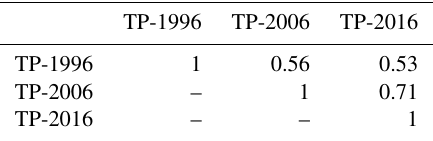
Table 5. Kappa coefficient statistics for three